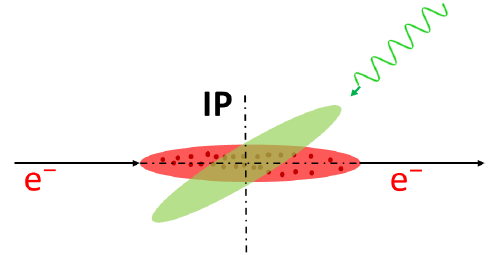
Figure 9. Geometry of the electron (red) and photon (green) bunches interaction at the